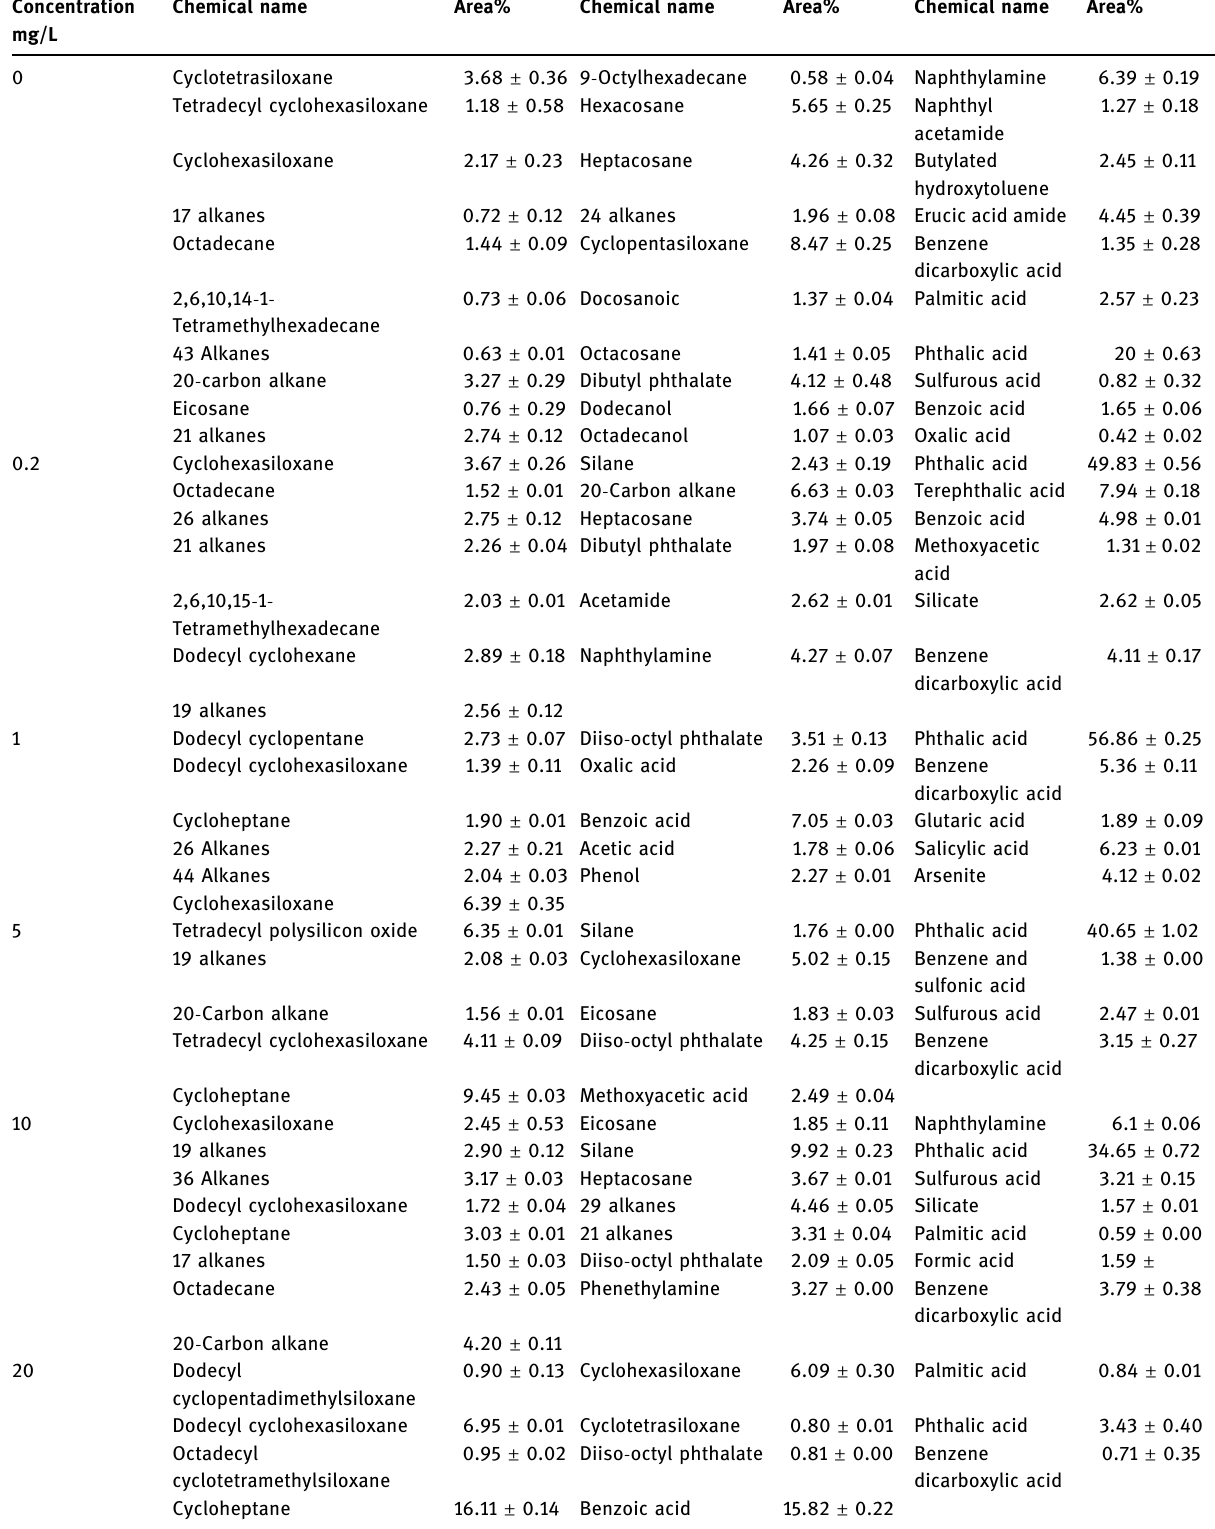
Table 1: Major root exudates of Pistia stratiotes exposed to a concentration gradient of phosphorus Concentration